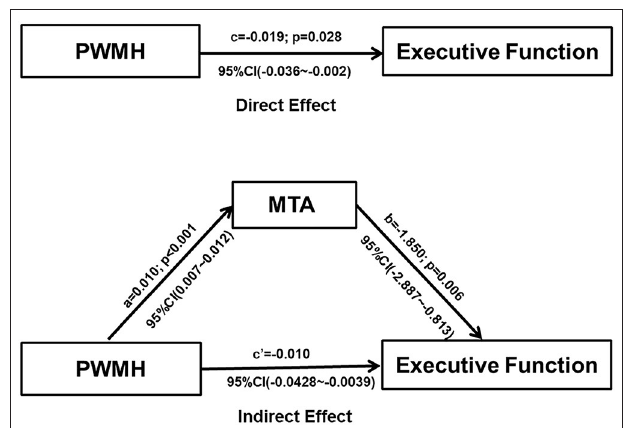
FIGURE 4 | Graphical illustration of the direct and indirect effects of PWMH volume and MTA on cognitive functioning. Each path of the connection, standard coefficient (a, b, c, c’), and p -value were shown. Mediation analysis revealed that the association between PWMH and executive function was mediated by MTA (Indirect effect: − 0.01, 95% CI: − 0.0428 to − 0.0039). PWMH, periventricular white matter hyperintensities; MTA, medial temporal atrophy, the ratio of the ipsilateral lateral subventricular horn to hippocampal